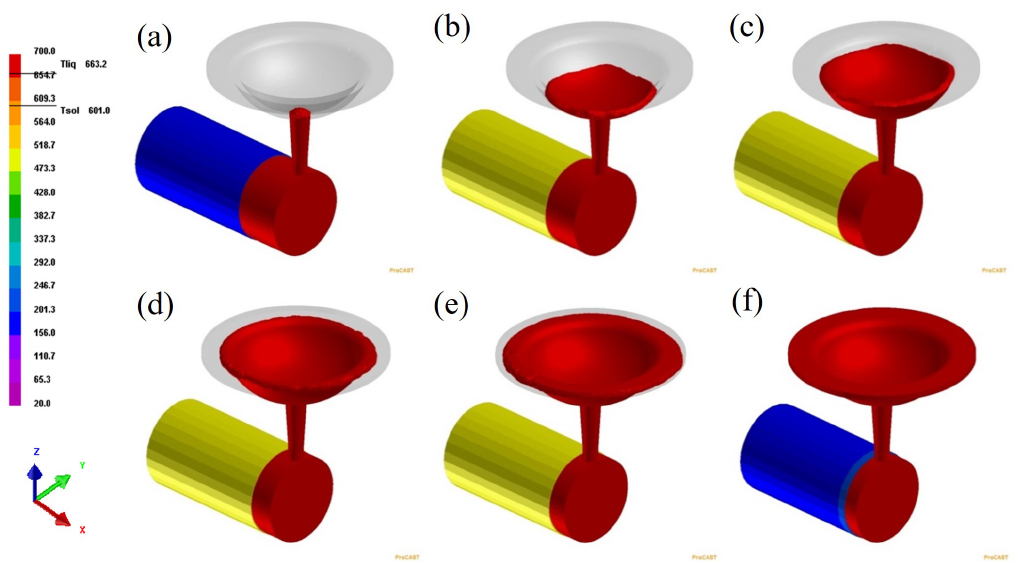
Figure 4. Temperature cloud diagrams for different filling rates when the punch movement rate was 0.1 m/s: ( a ) 0%; ( b ) 20%; ( c ) 40%; ( d ) 60%; ( e ) 80%; ( f ) 100%.